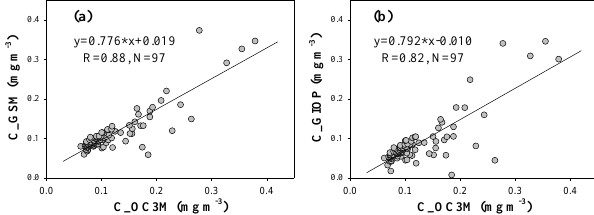
Fig. 6. Scatter plots showing the correlation between (a) C_OC3M and C_GSM; (b) C_OC3M and C_GIOP at SEATS.